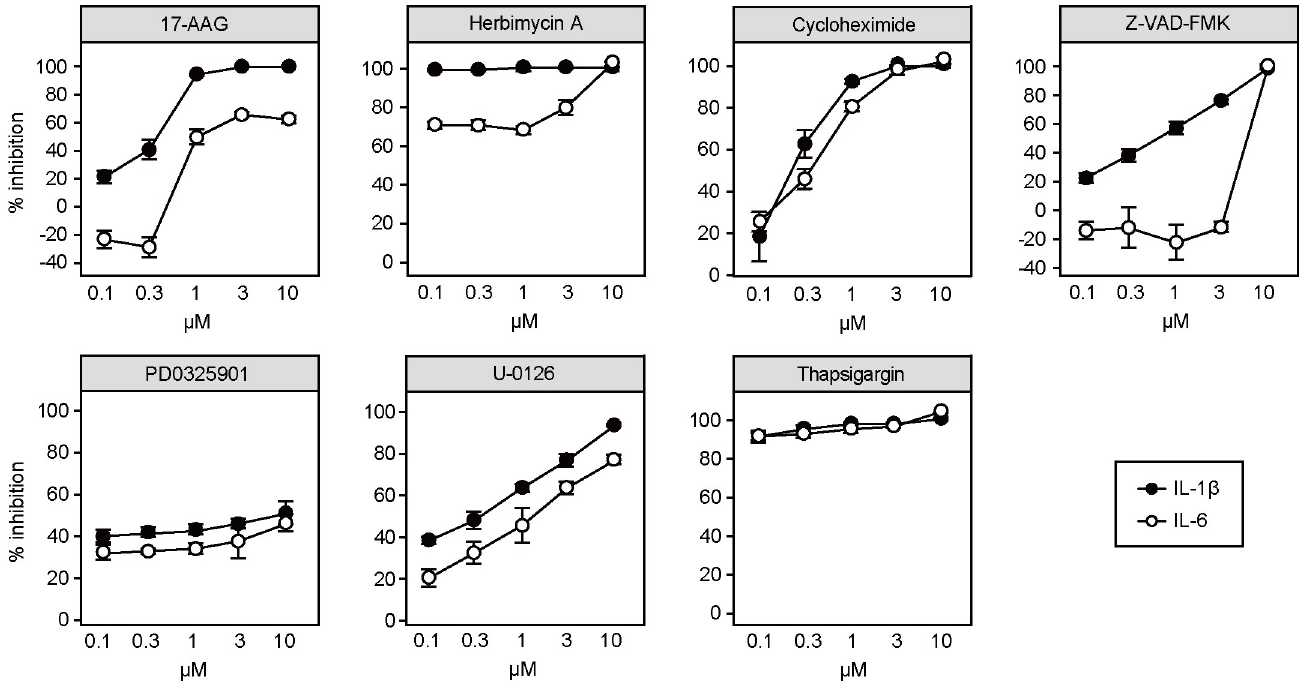
Fig 4. Hit validation with PBMCs. Dose-dependent inhibition of IL-1 β (closed circles) and IL-6 (open circles) secretion from PBMCs of a healthy donor. Cells were stimulated with LPS (20 ng/ml) for 4 hours and ATP (2 mM) for an additional hour. Bars show the mean ± SD of four wells.